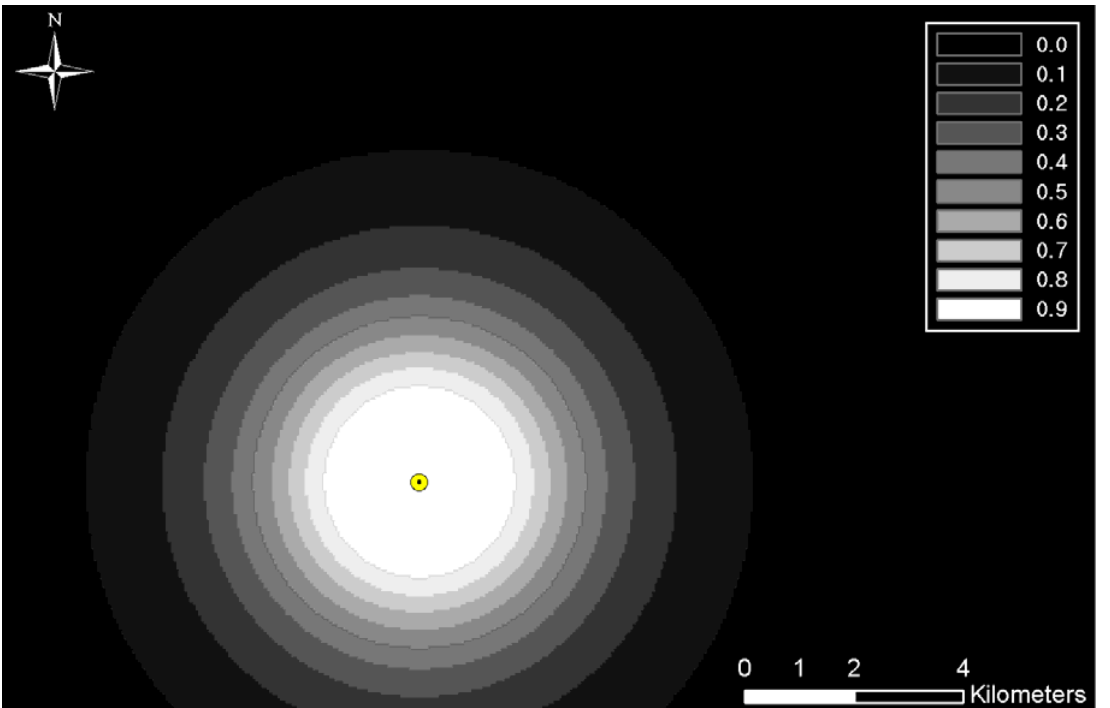
Figure 6. Detection probability of TOD